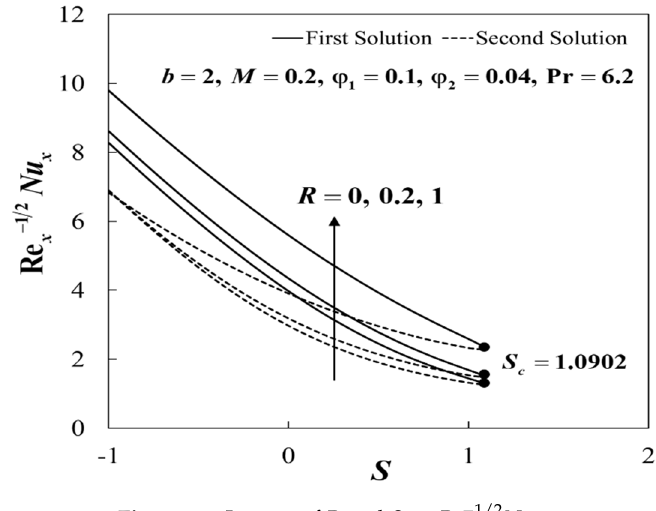
Figure 16. Impact of 𝑅 and 𝑆 on 𝑅𝑒 (cid:3051)(cid:2879)(cid:2869)/(cid:2870) 𝑁 𝑢 (cid:3051) .